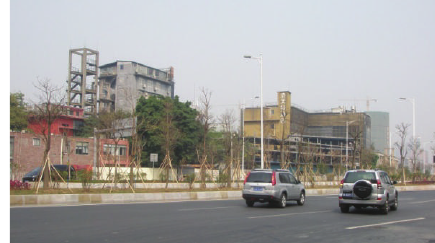
Figure 4: Under-construction projects.